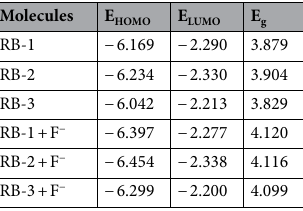
Table 2. The energy values of HOMO, LUMO of RB1-RB3 chemosensors without and with F − ions. E g = E LUMO − E HOMO .